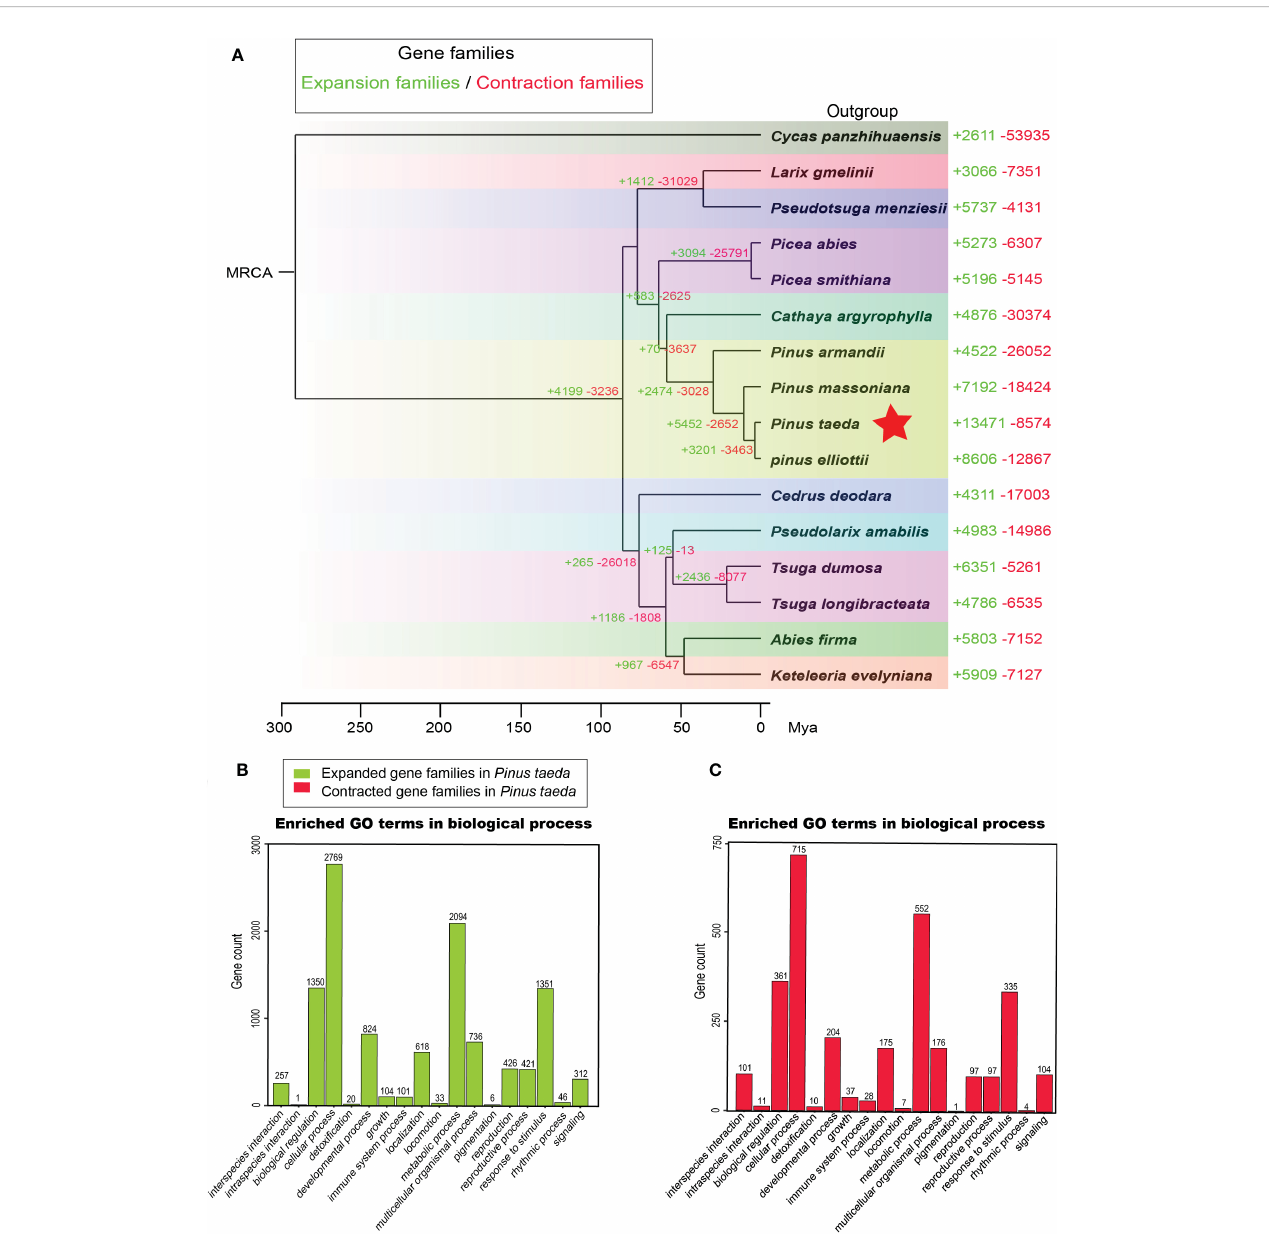
FIGURE 4 Gene family analysis. (A) The evolution of gene families in 15 species of Pinaceae and one outgroup (Cycadaceae: Cycas panzhihuaensis ). The corresponding numbers indicate gain (expansion) or loss (contraction) of gene families in speci fi c species. (B) Gene Ontology (GO) enrichment analysis of expanded gene families in Pinus taeda . (C) Gene Ontology (GO) enrichment analysis of contracted gene families in Pinus taeda